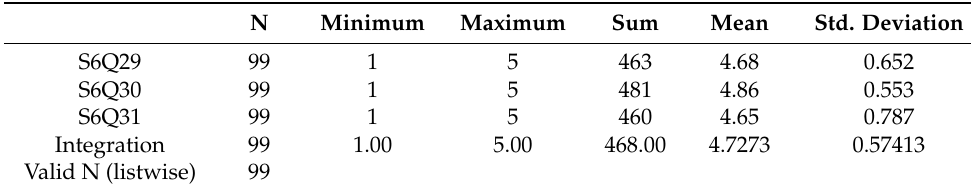
Table 7. Descriptive statistics of perception of Integration stage.